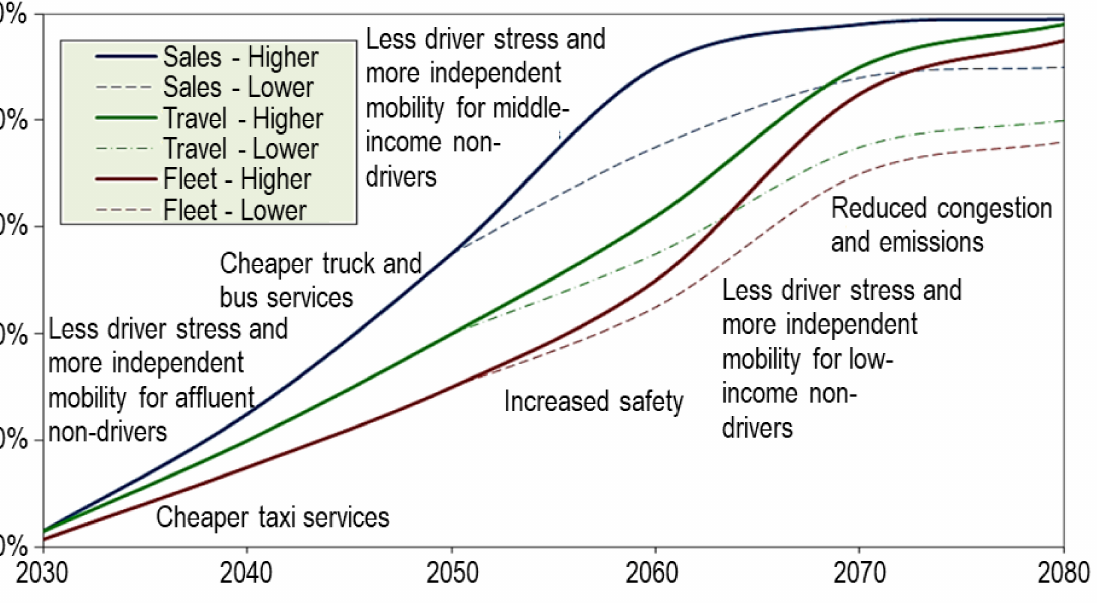
Figure 1. Projected Autonomous Vehicle Sales, Fleet and Travel from 2030 to 2080. Adapted with permission from